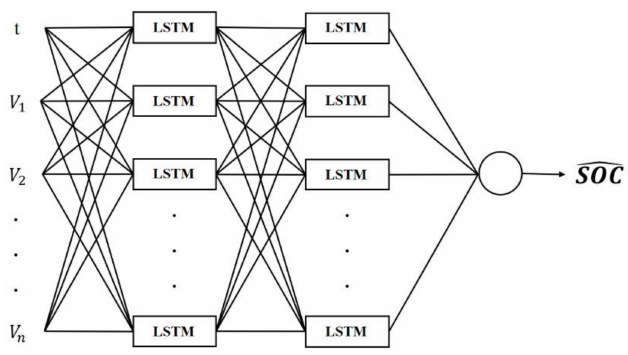
Figure 11. LSTM structure for the SOC estimation model.